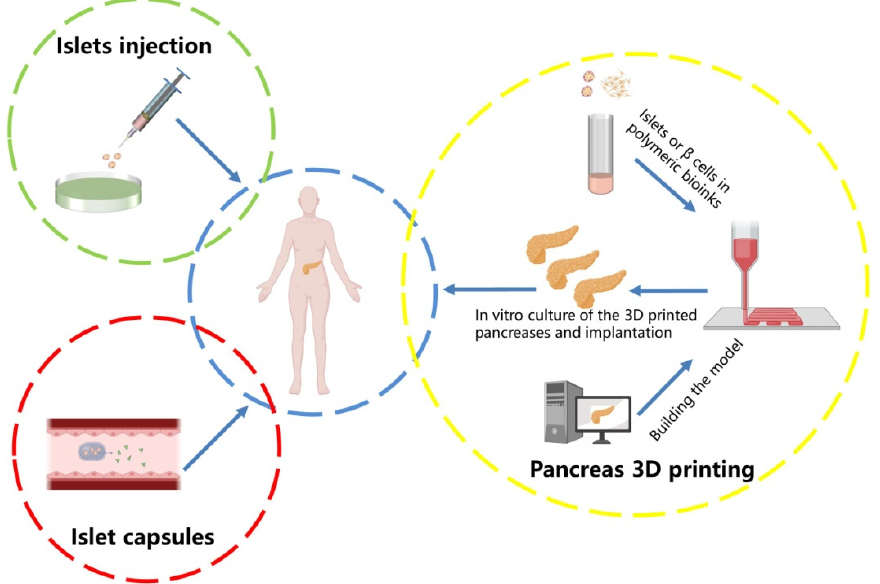
Figure 1. Diabetes treatment strategies. The traditional treatment for Type 1 diabetes is to inject insulin or take islet capsules. With the development of science and technologies, 3D printing implantable pancreatic organs is becoming more and more popular.